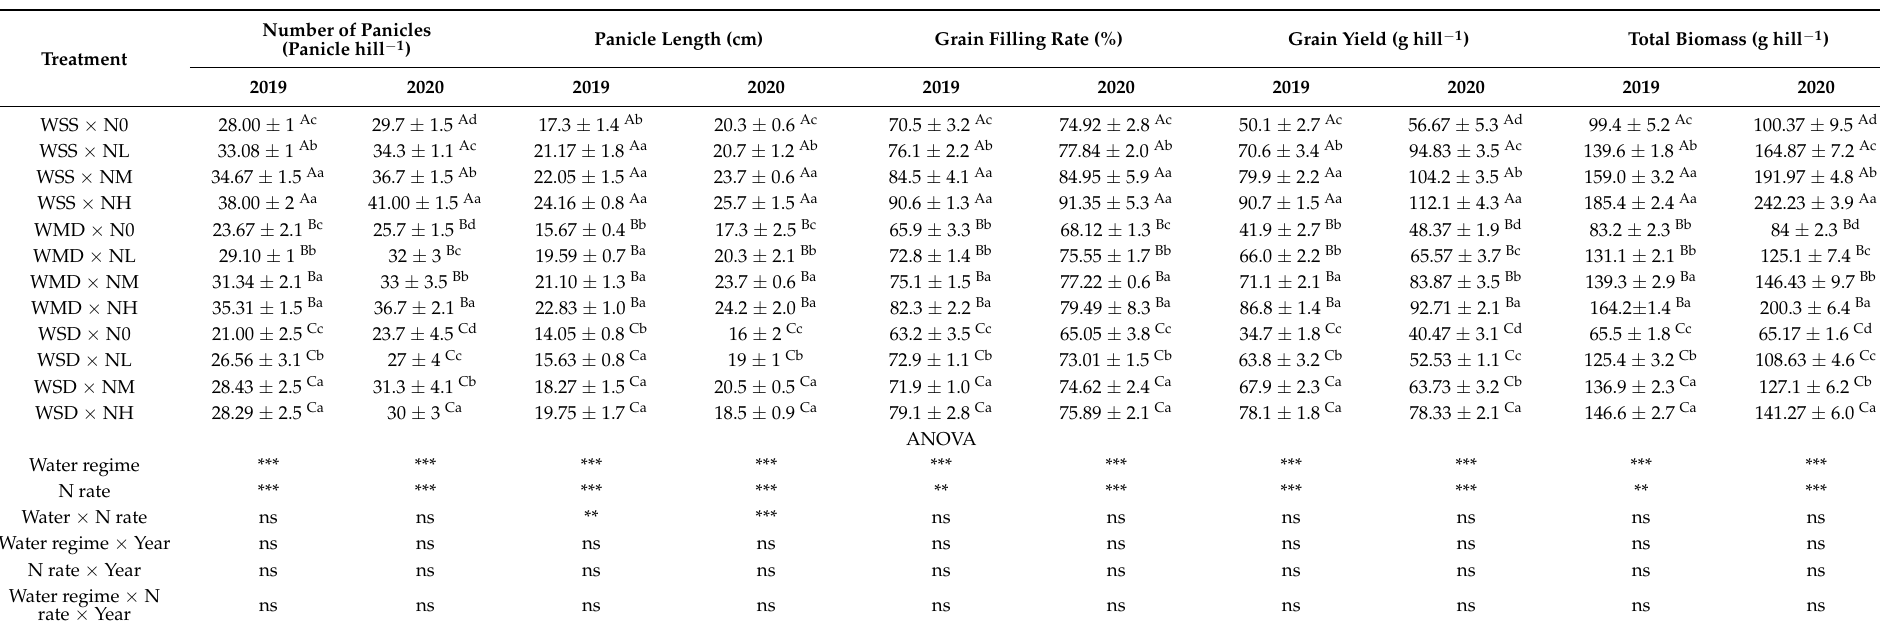
Table 3. Mean values of rice yield indicators for different irrigation techniques and N fertilizer rates, and a summary of the ANOVA analysis of the main effects of different irrigation techniques and N fertilizer rates on yield indicators of